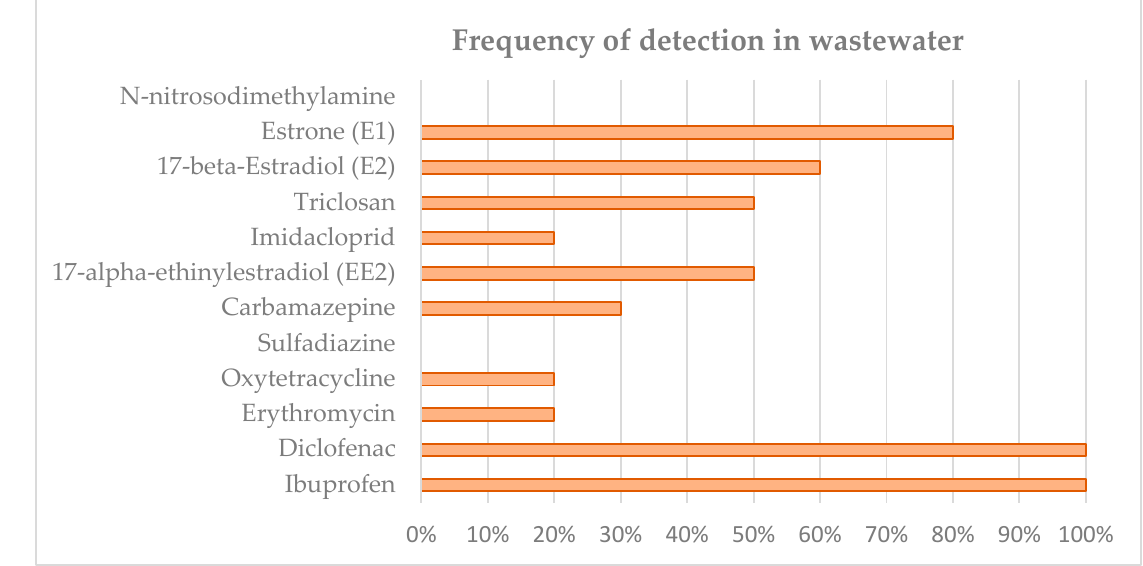
Figure 7. Frequency of detection of emerging pollutants at the inlet of WWTP B.